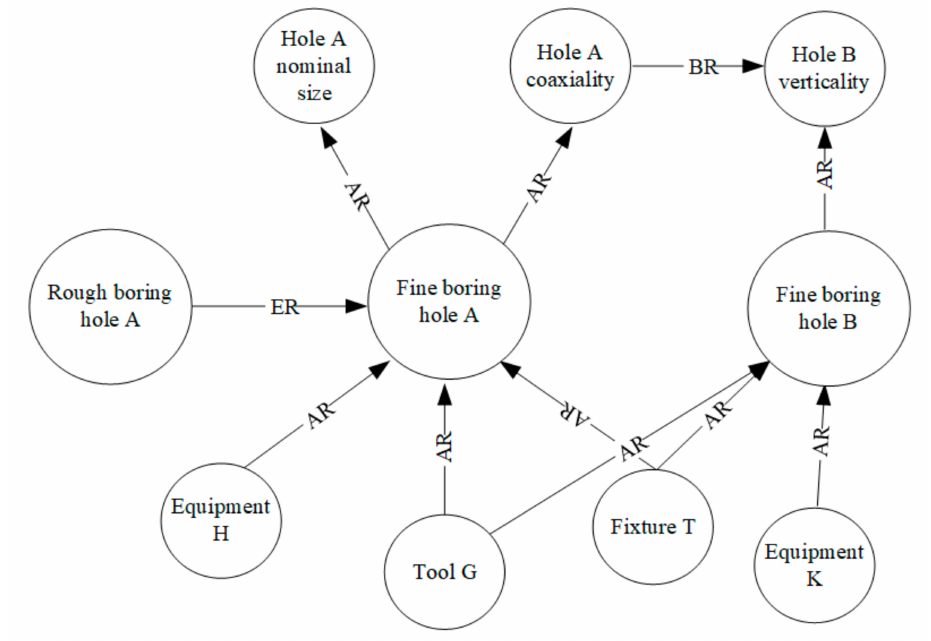
Figure 3. Process error transfer sub-network.